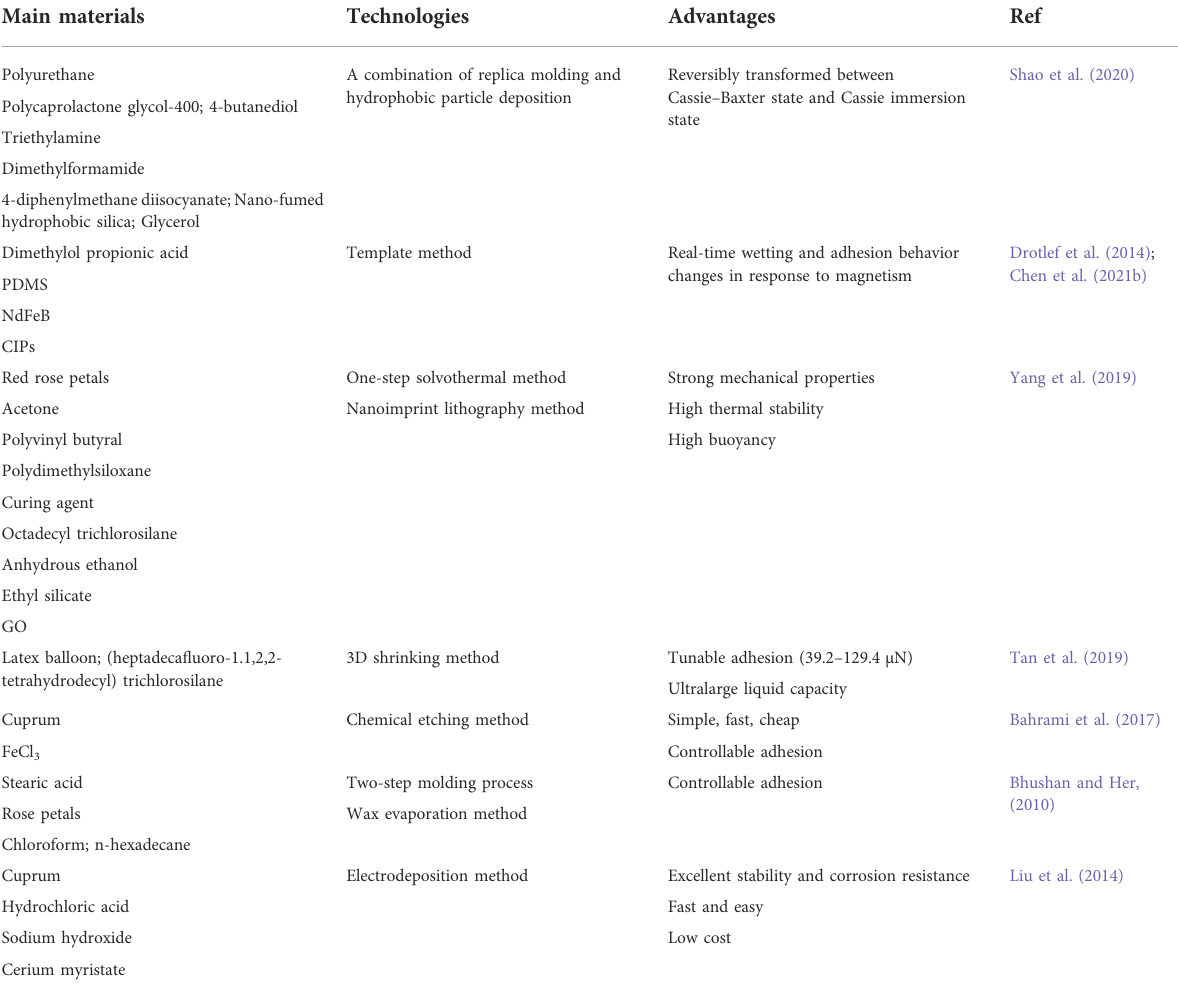
TABLE 3 Bionic product with rose petals as